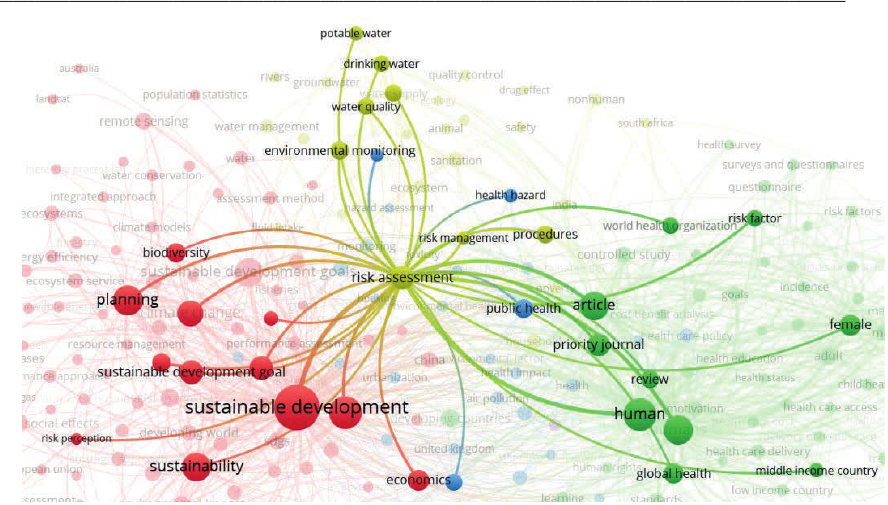
Fig. 4. Relationships of risk